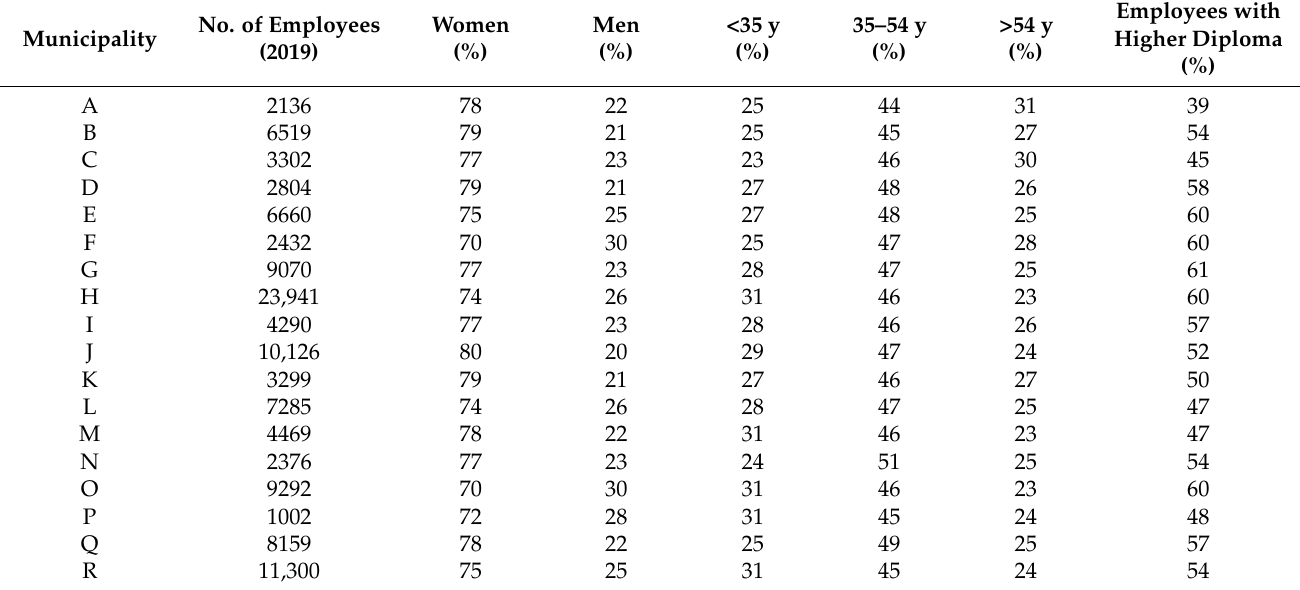
Table A2. Number of employees and age structure among the employees in participating municipalities.